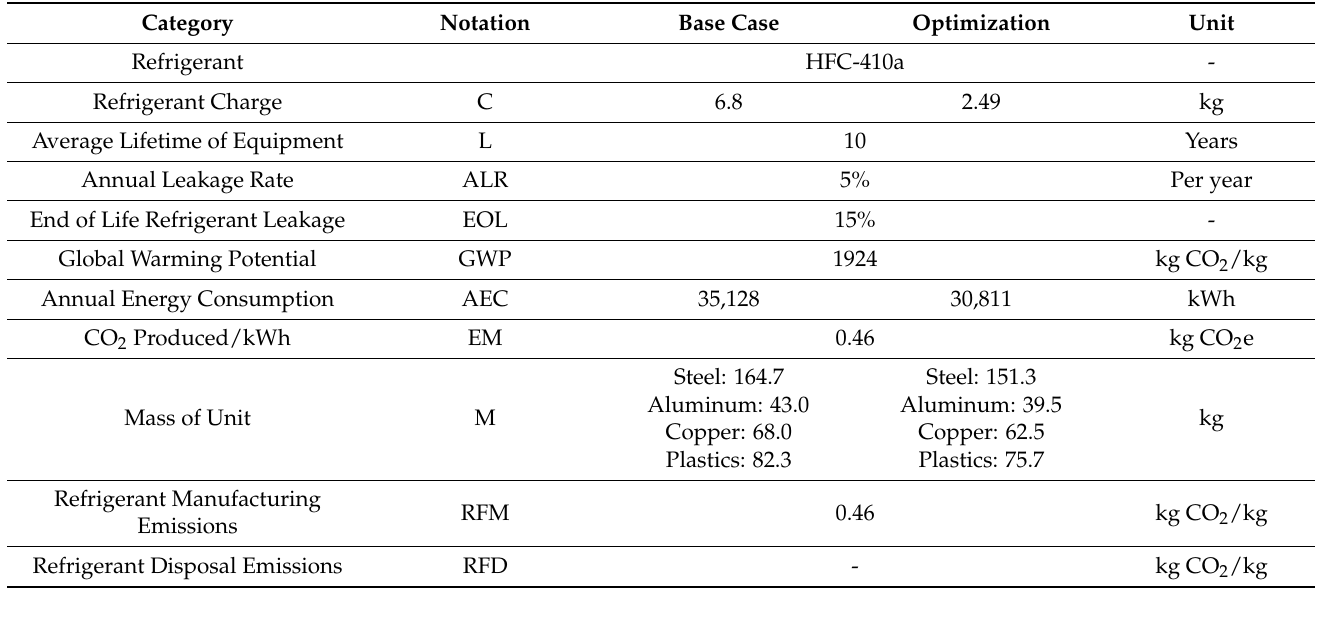
Table 8. Specifications of life cycle climate performance.